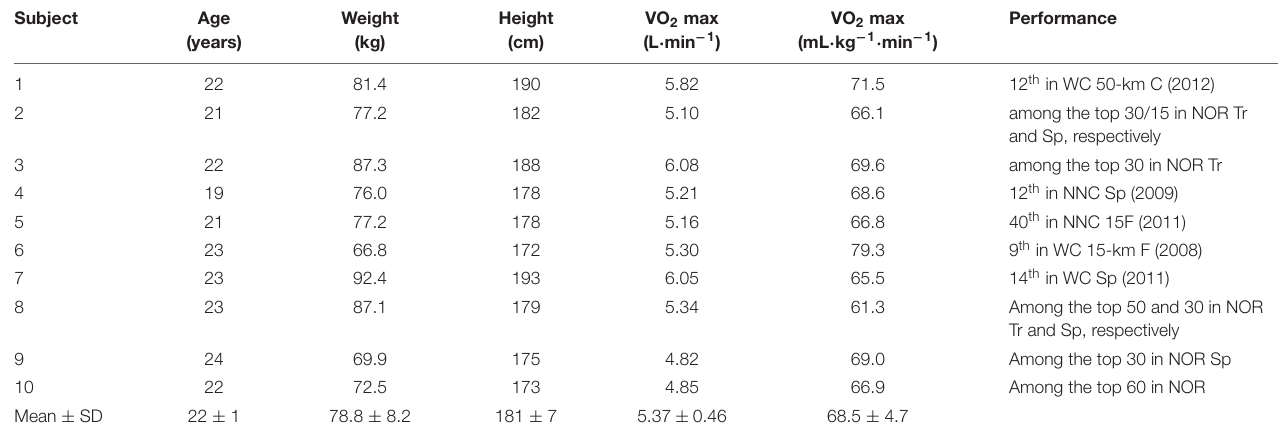
TABLE 1 | Characteristics of the 10 elite male cross-country skiers who participated in this